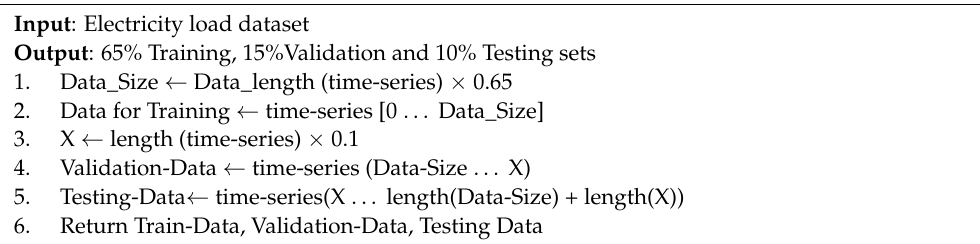
Algorithm 1: #This algorithm separated the electricity load dataset into training, validation and testing